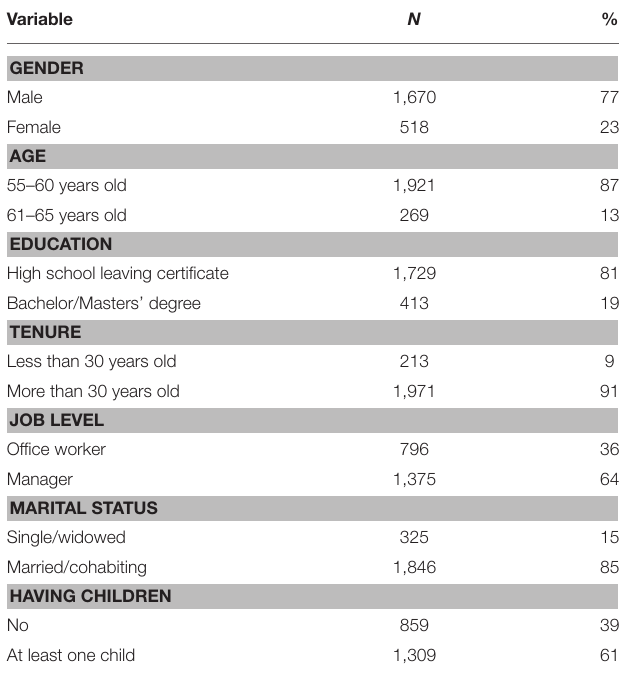
TABLE 1 | Socio-demographic characteristic of the sample ( N =